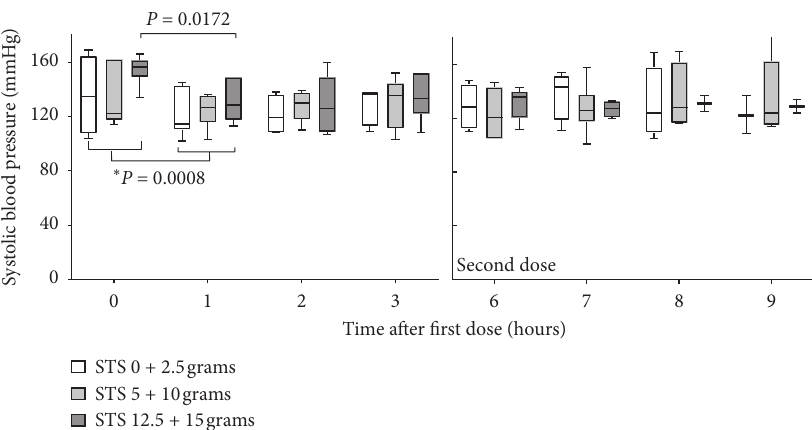
Figure 2: Systolic blood pressure course for combined dose